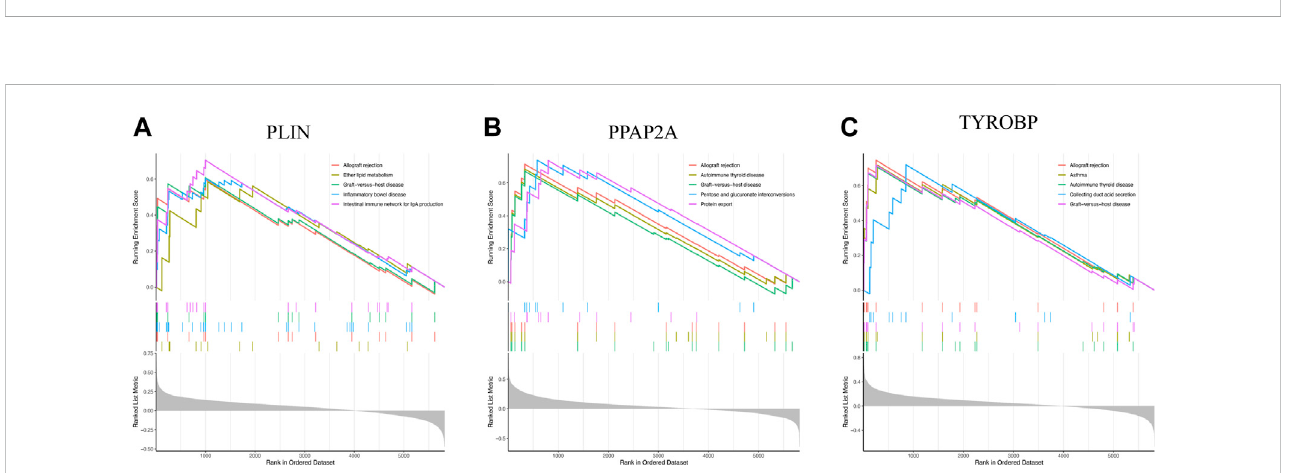
FIGURE 8 (A) UpGSEA results of PLIN (B) UpGSEA results of PPAP2A. (C) UpGSEA results of